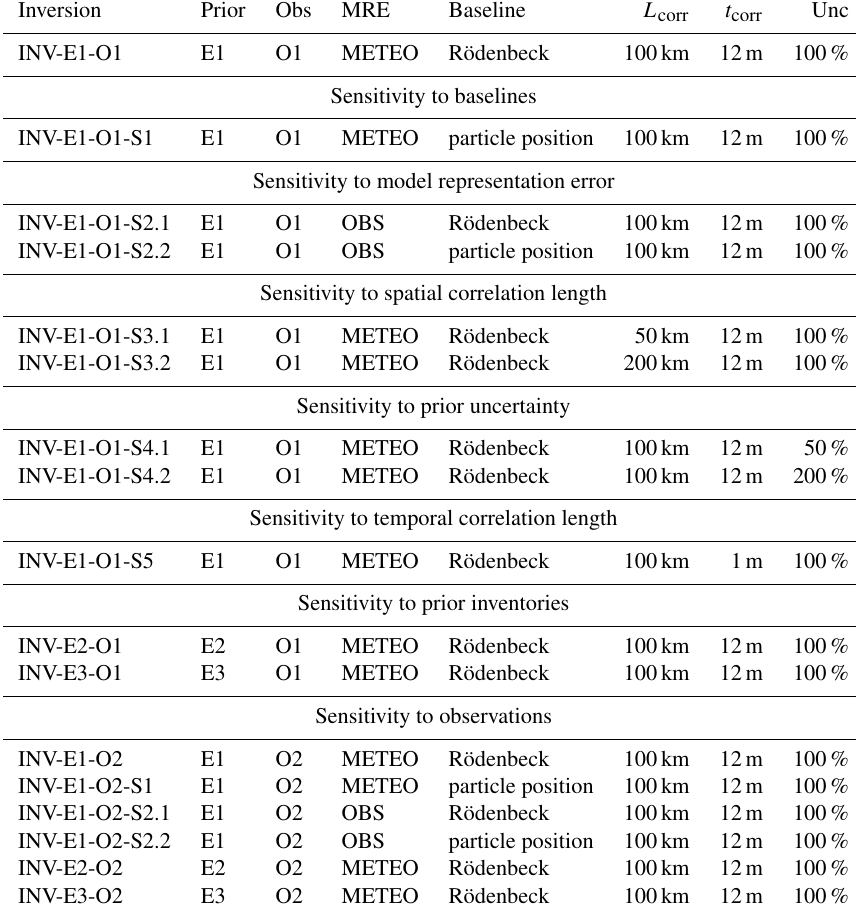
Table 3. FLEXVAR sensitivity inversions. The column “Prior” lists the emission data set used (Table 2) and column “Obs” the observation data set (Table 1). “MRE” is the applied model representation error (Sect. 2.2.3), and “Baseline” lists the applied approach to calculate the baselines (Sect. 2.2.2). “ L corr ” is the applied spatial correlation length constant, “ t corr ” the temporal correlation scale constant, and “Unc” the assumed 1 σ uncertainty of total emissions per grid cell and month (Sect.